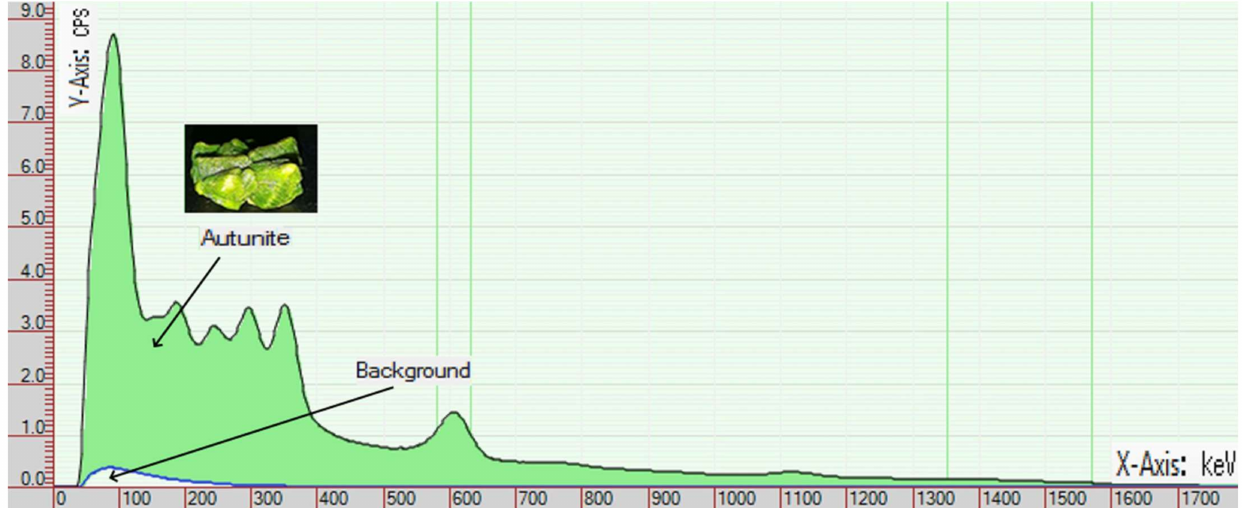
Figure 2. Shows the radiation spectrum of one of the Autunite minerals used in the experiments (Counts per second (CPS), kiloelectron volt (keV)).